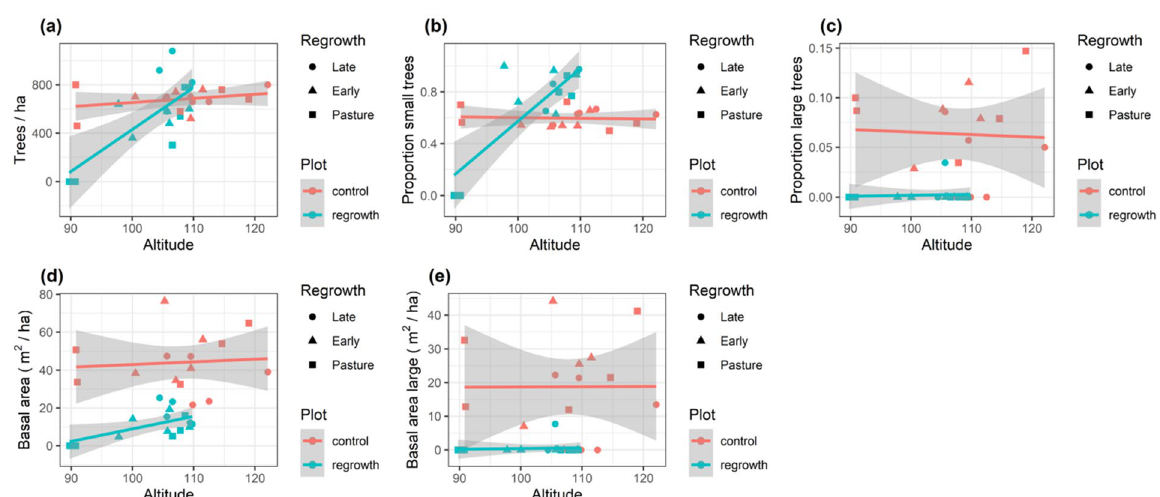
Figure 2. Forest structure along a lowland Amazon regrowth gradient. Showing trends in ( a ) number of trees (> 10 cm DBH) per ha, ( b ) proportion of small trees (10–20 cm DBH), ( c ) proportion of large (> 60 cm DBH) trees, ( d ) basal area and ( e ) basal area of large (> 60 cm DBH) tree in 30 plots (15 control and 15 regrowth). Lines and shaded areas are mean values and 95% confidence intervals from linear models illustrating trends in basal area with increasing altitude (masl). Points with different shapes represent different regrowth